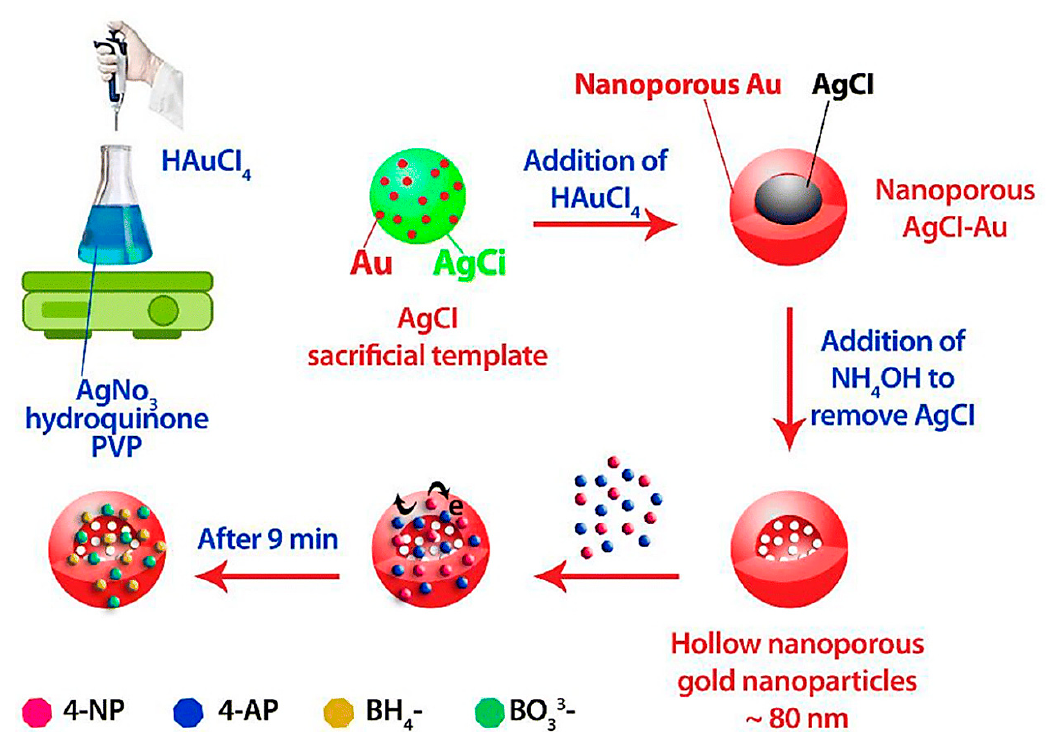
Figure 3. Chemical synthesis of AuNPs loading with different agents.